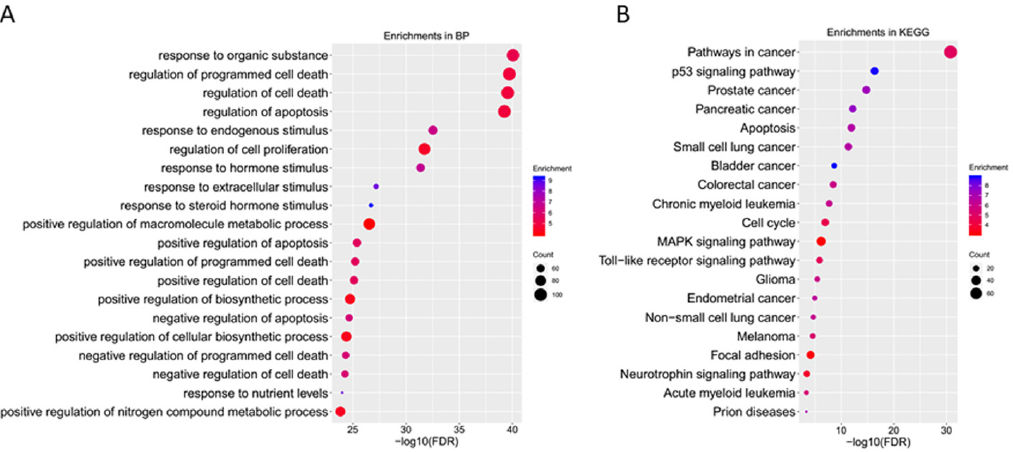
Figure 4. GO ontology and KEGG pathway enrichment of the core targets. ( A ) Biological processes and ( B ) KEGG pathways involved in genistein’s action against human cervical cancer.